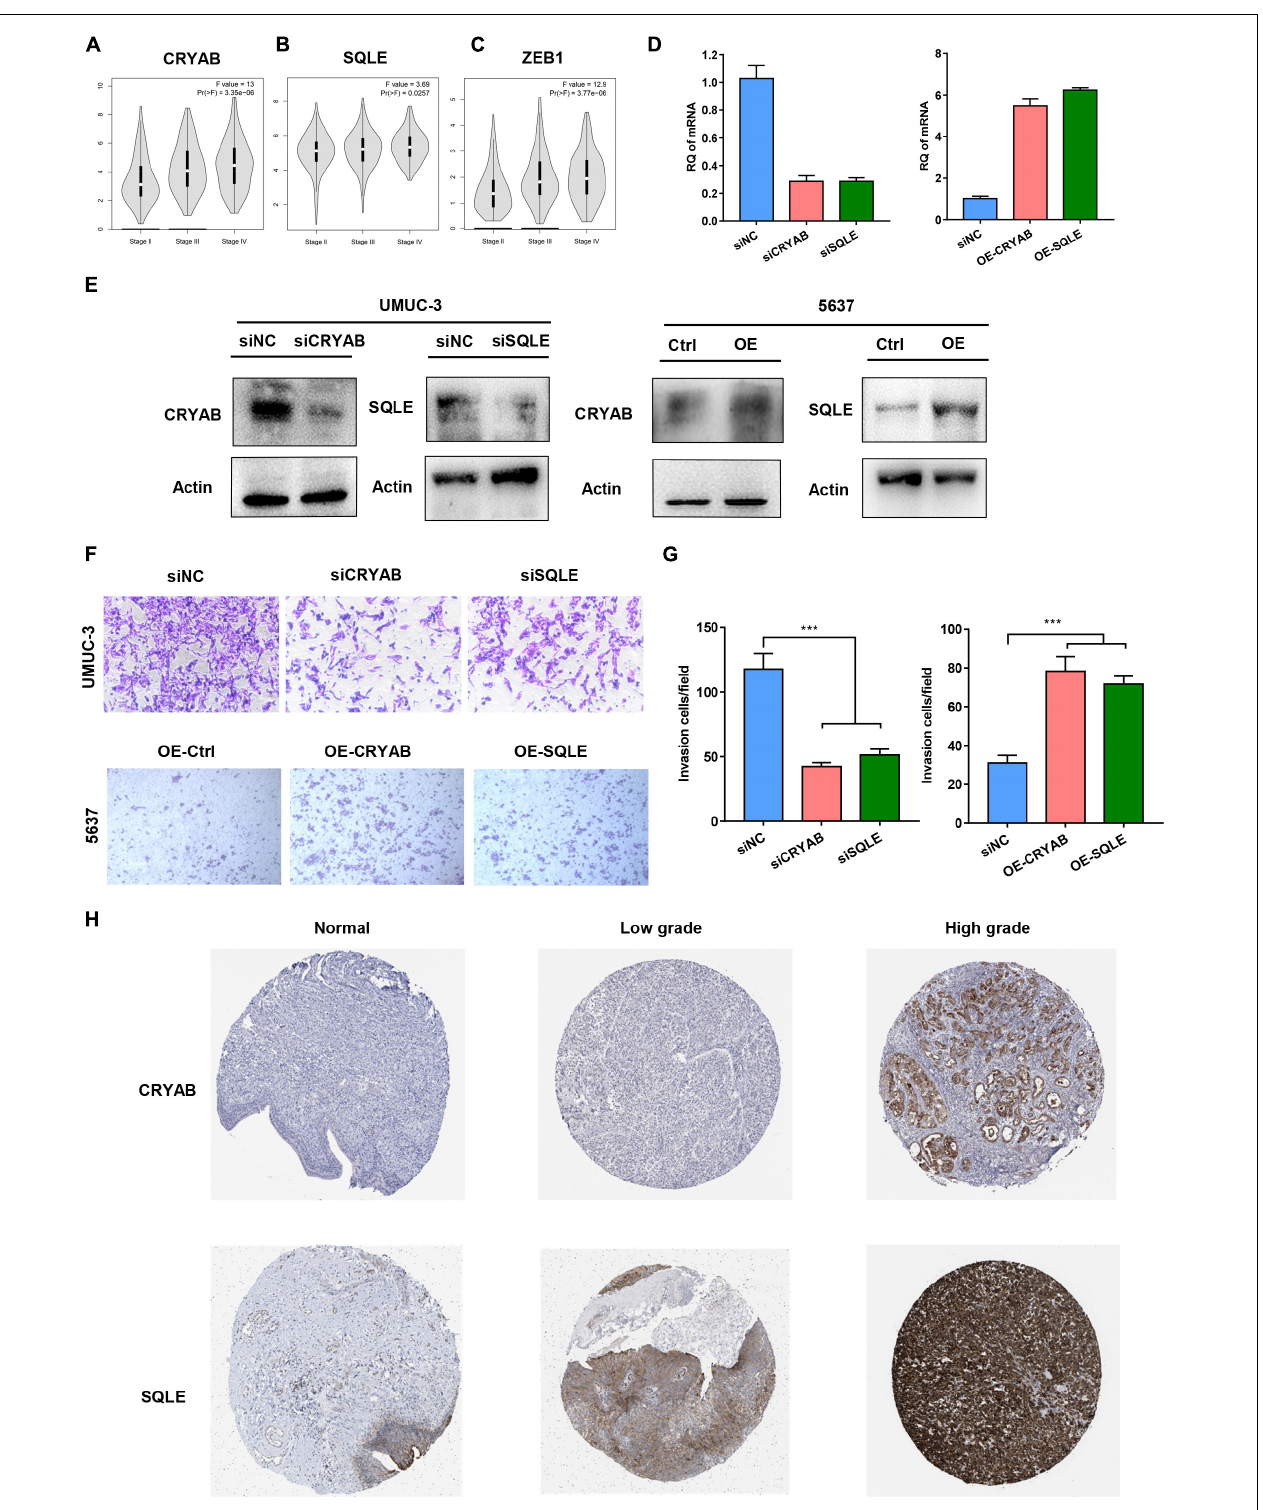
FIGURE 8 | Functions of the Identified Biomarkers in BC Invasion. (A–C) The correlation between expression of CRYAB, SQLE, ZEB1, and the clinical stage in different BC stages. (D,E) Knockdown and overexpression efficiency was confirmed by real-time RT-PCR and Western blot. (F,G) Transwell invasion assay analyzed the effect of CRYAB and SQLE knockdown and overexpression on cell invasion in vitro . Scale bar, 100 µ m. (H) Immunohistochemical (IHC) staining of the expression of CRYAB and SQLE in normal urothelium and BC tissues with different degree of malignancy. *** p < 0.001.